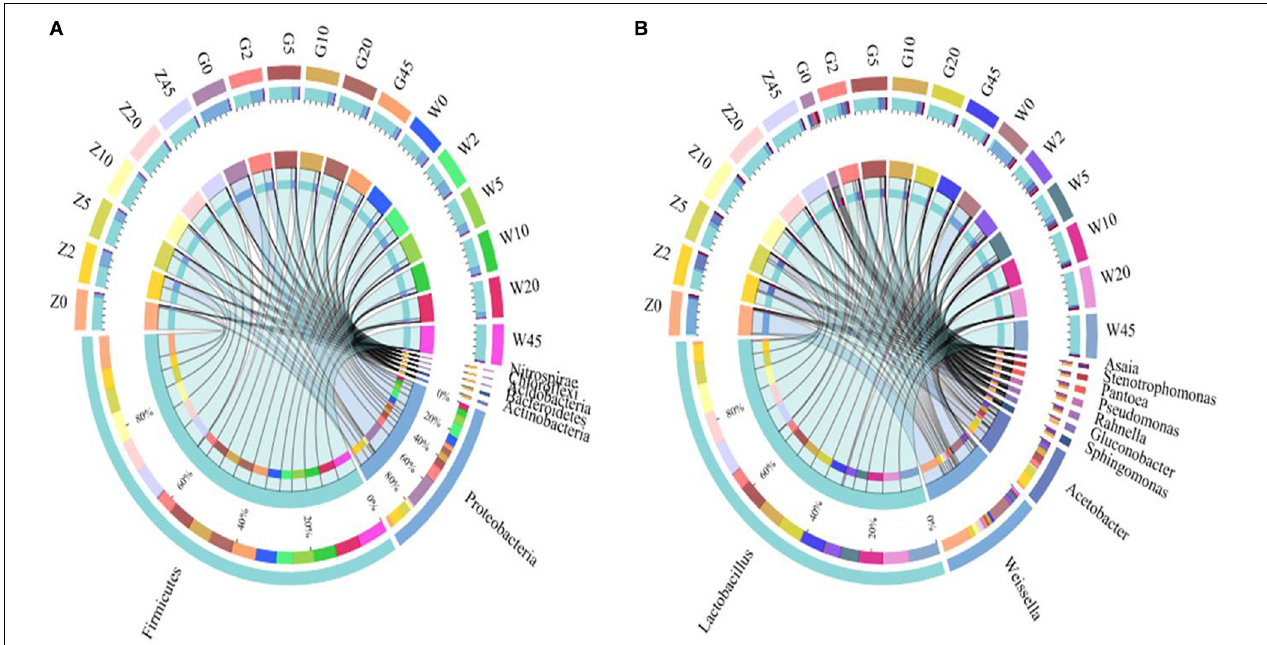
FIGURE 3 | Circos map of bacterial communities at the phylum (A) and genus levels (B) for whole-plant maize silage.